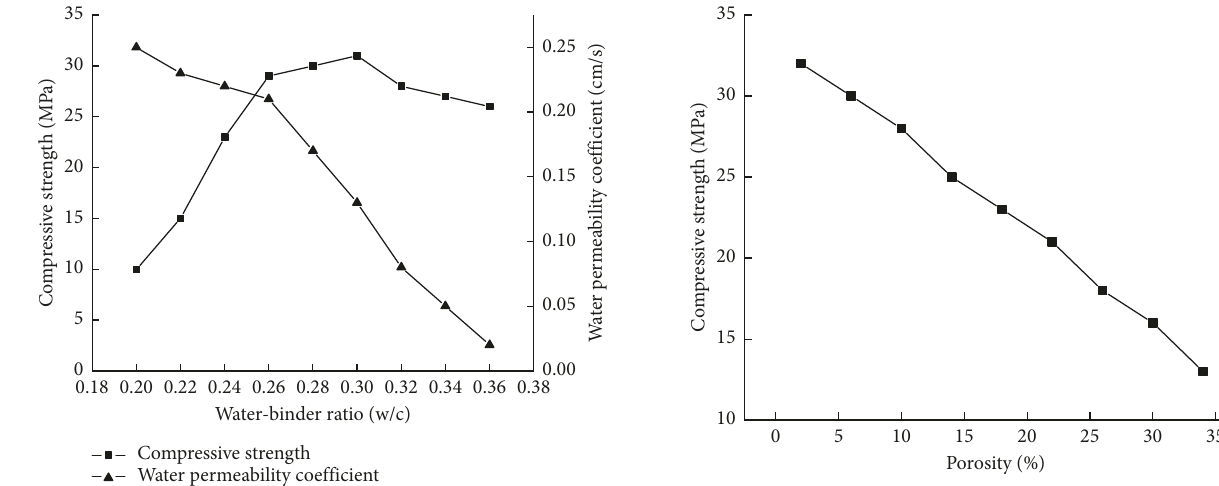
Figure 10: Comprehensive relationship between water-binder ratio residual strength and water permeability coefficient.